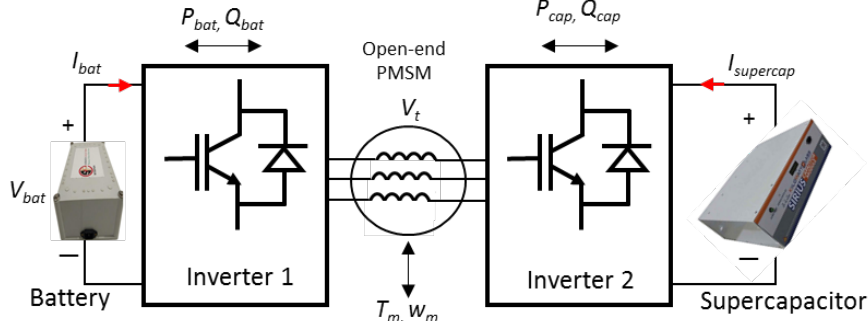
Figure 13. Single stage HESS topology adapted from [52] for its integration in EVs.